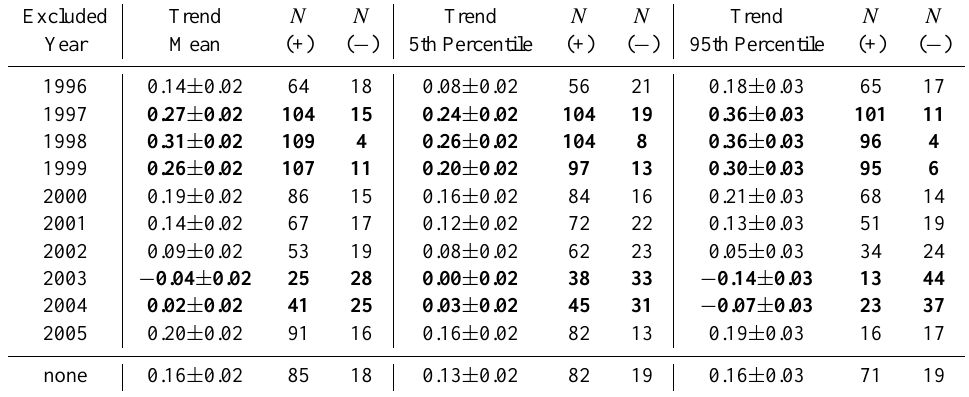
Table 3. A summary of European-averaged trends (where N = 158 sites) in O 3 mean, 5th and 95th percentiles during the period 1996–2005 with the exclusion of data from individual years. N (+) and N ( − ) the number of sites with significant ( p < 0.1) positive and negative trends respectively. Bold text highlights those years with high influence on trends during the overall 1996–2005 period, see text for